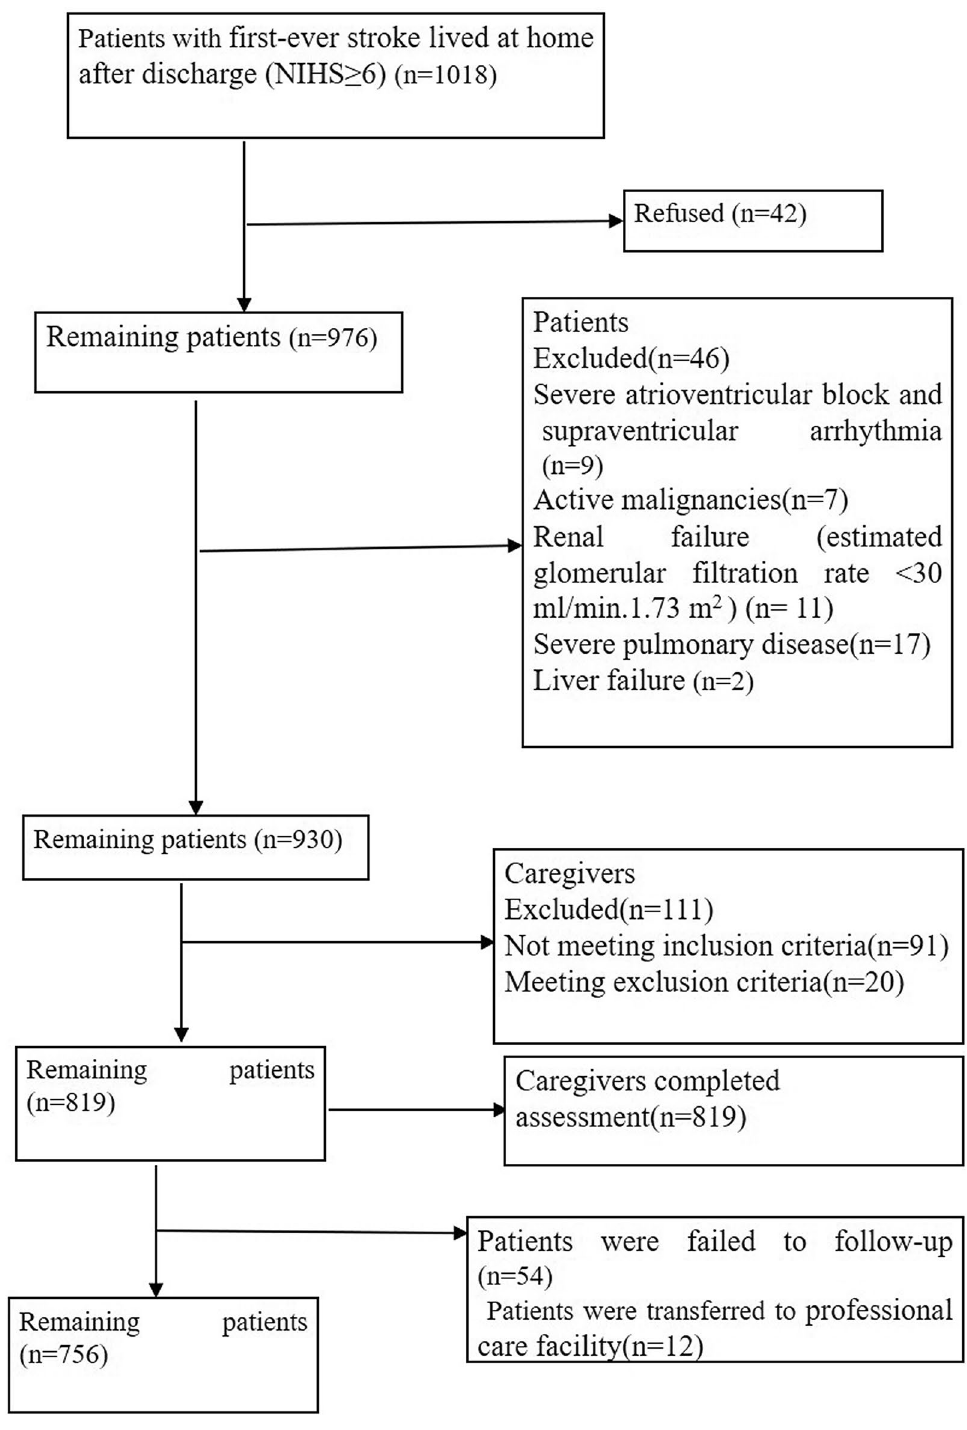
Figure 1. Patient’s and caregiver’s